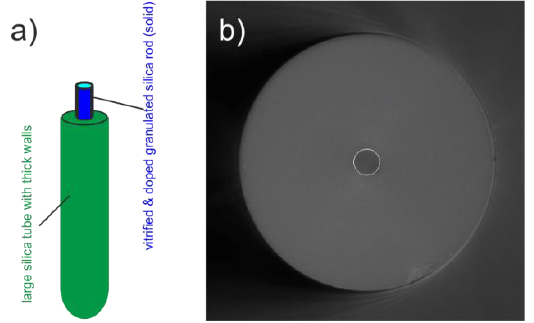
Figure 15. Double-clad (DC) LMA fiber derived from sol-gel granulated silica method: ( a ) preform assembly; and ( b ) fiber geometry: microscope image (white ring indicates the core) [7]. Table 6. Geometry parameters of the self-made double-clad fiber [7]. Core diameter: 22 µm Cladding diameter: 250 µm